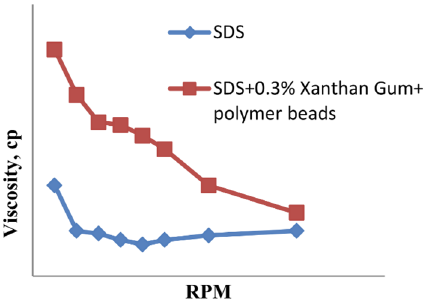
Fig. 9 Rheological properties of different types of foam. (Suradi et